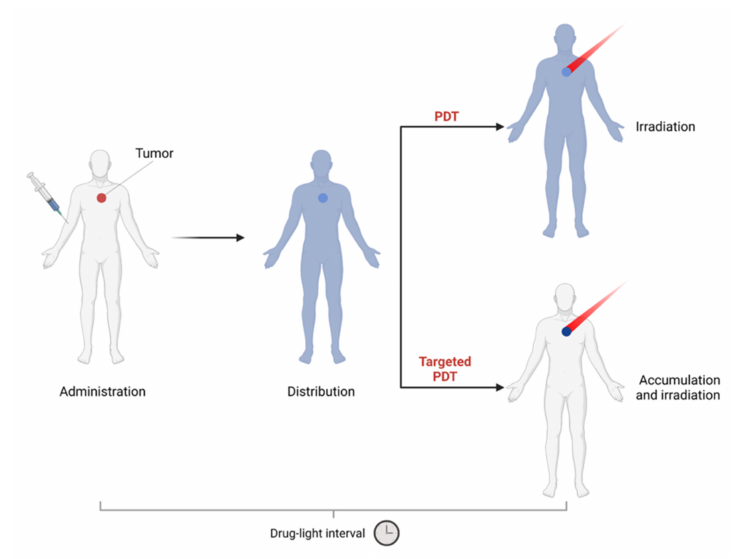
Figure 3. Therapeutic application of PDT or targeted PDT. The patient is administered with the photosensitizer, which concentrates at the tumor. The photosensitizer is then activated by light, destroying the tumor. Created with